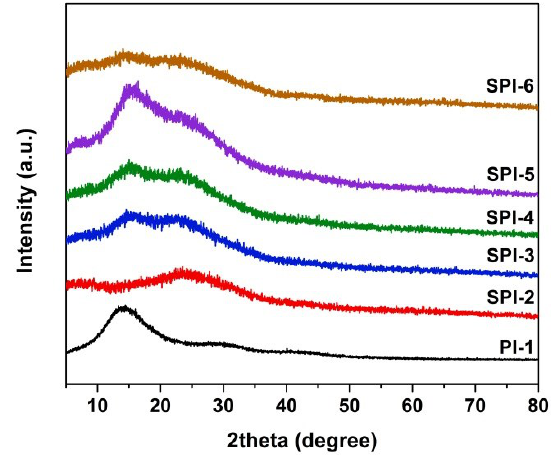
molecular weight; M w : weight average molecular weight; PDI: polydispersity index, PDI = M w / M n ; 3 ++: Soluble; +: partially soluble; −: insoluble. GBL: γ -butyrolactone; CPA: cyclopentanone; THF: tetrahydrofuran.